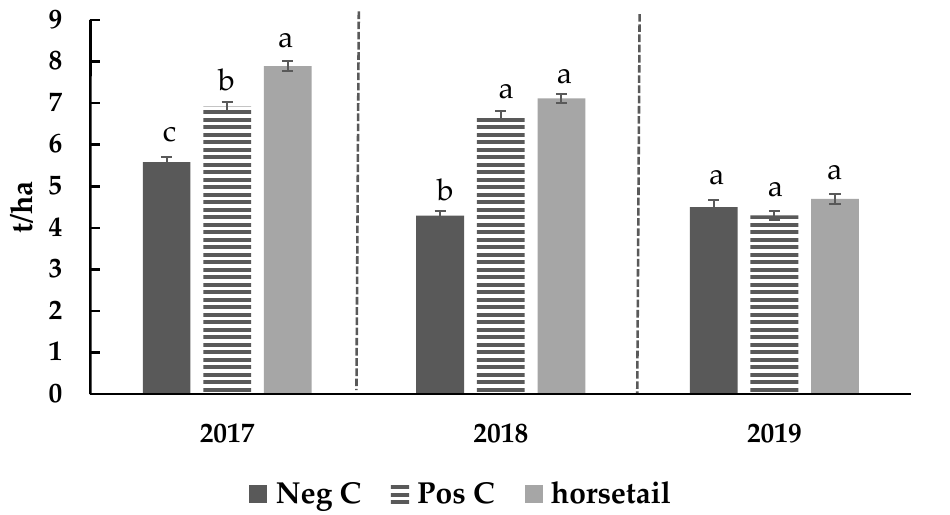
Figure 5. Durum wheat yield in Cu (positive C) and horsetail macerate treatments compared with untreated control (Neg